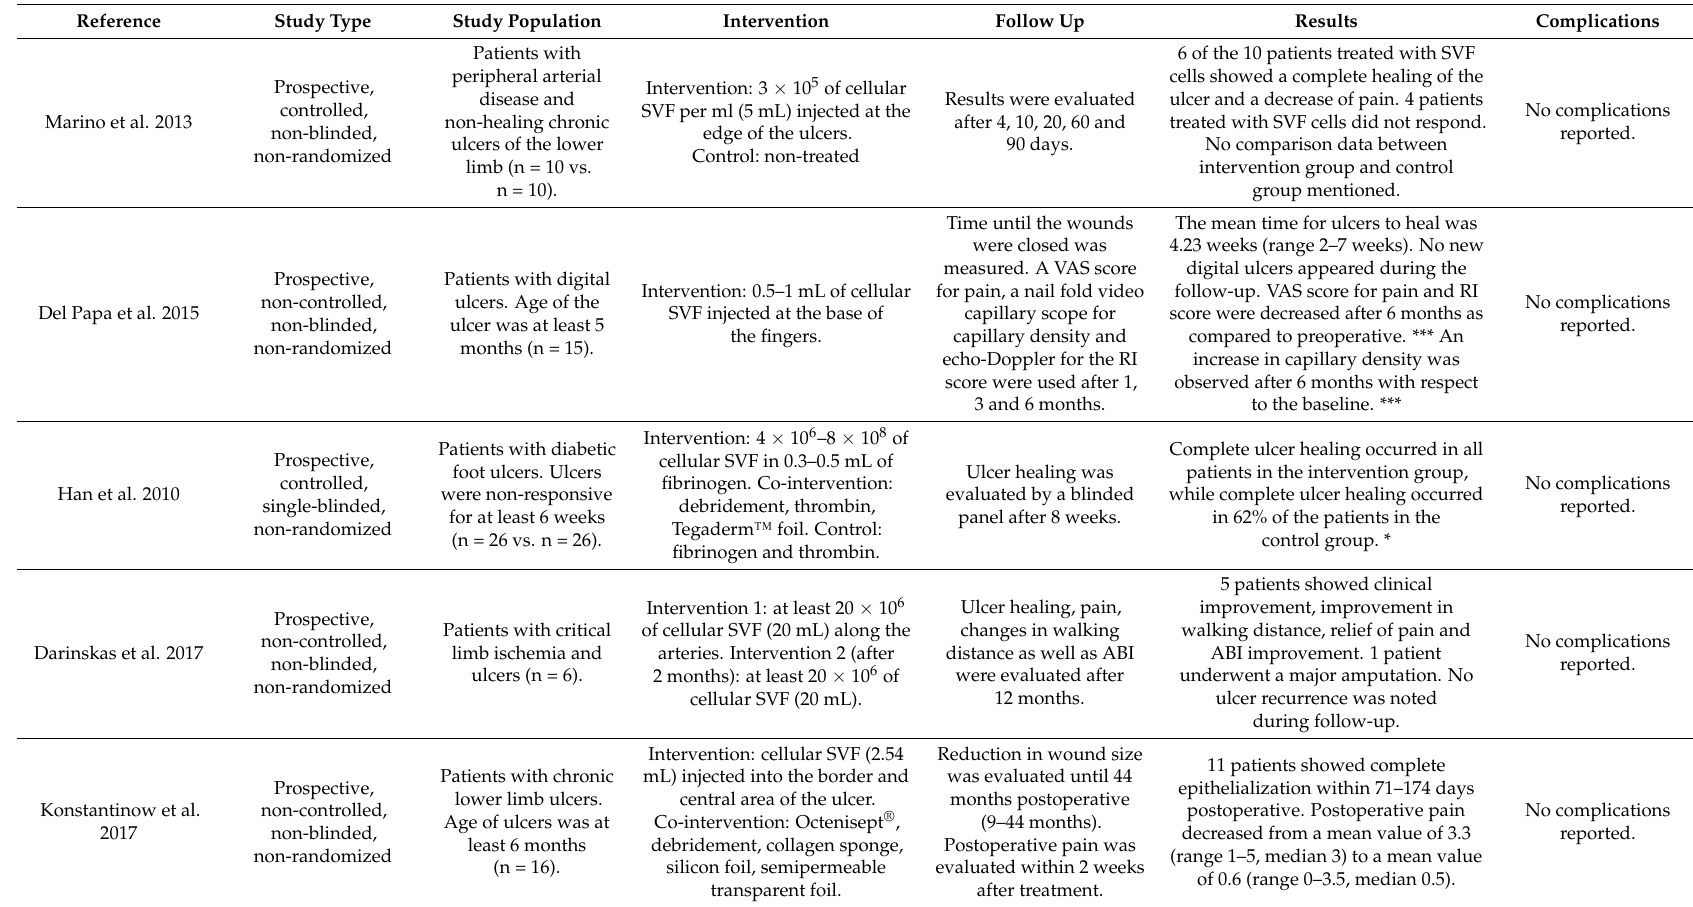
Table 2. Clinical studies of cellular stromal vascular fraction (SVF) as treatment of wound